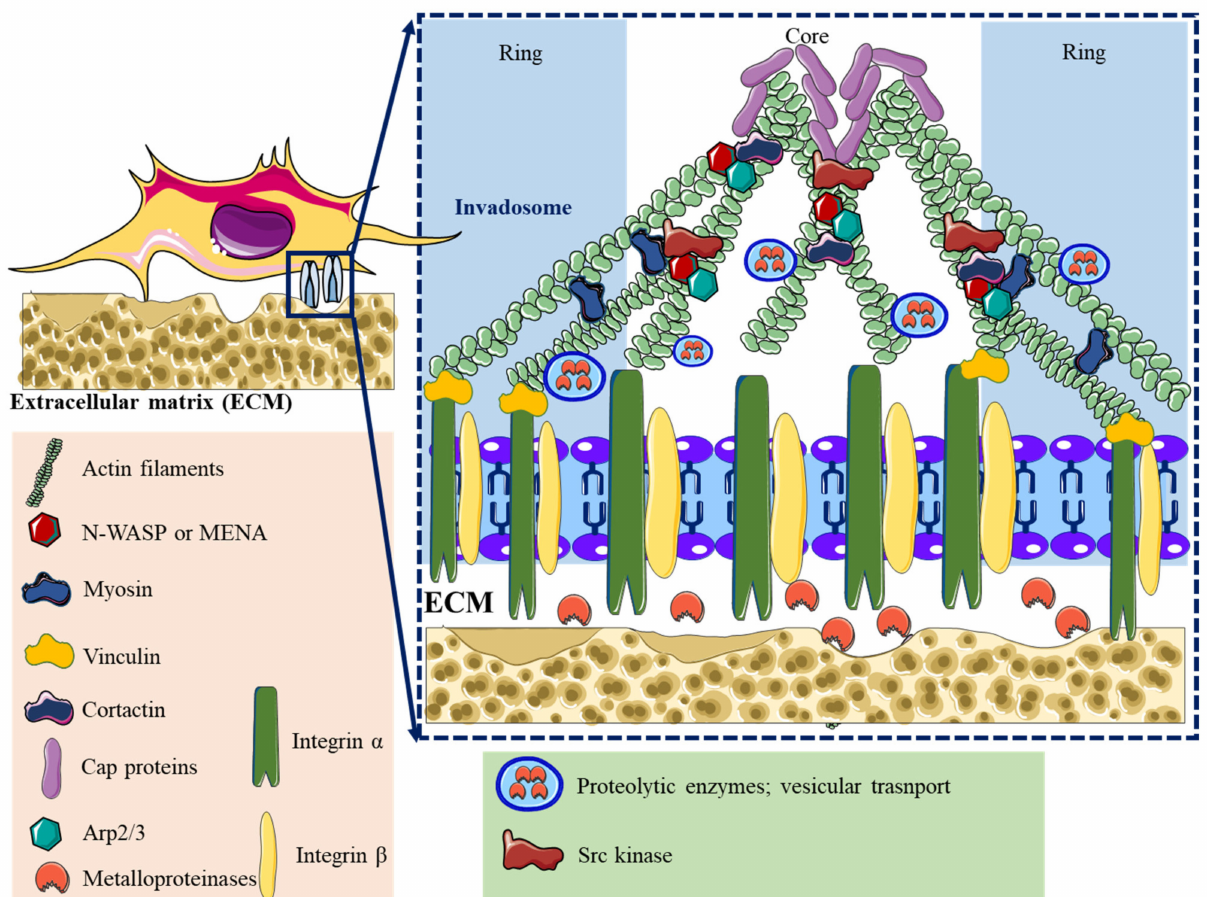
Figure 3. Schematic representation of invadosome (podosomes and invadopodia). Invadosomes mediates the ECM degradation through the secretion of several metalloproteinases and other proteases. The schematic simplifies the complex invadosome machinery to include those proteins that are most likely to be involved in its formation and structural